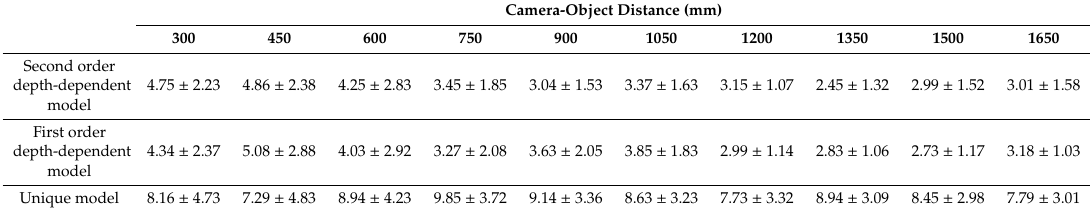
Table 1. Calibration error with 8-mm lens and parallel planes (mean and standard deviation) a